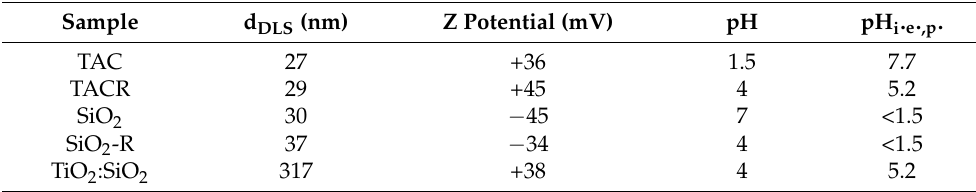
Table 1. Hydrodynamic diameter (nm), Z-potential (mV), and pH i . e . ,p . of pristine materials and TiO 2 -based